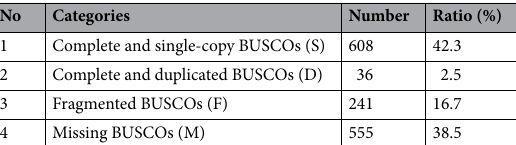
Table 2. Summarized benchmarks in BUSCO annotation from M. casturi scaffolds.